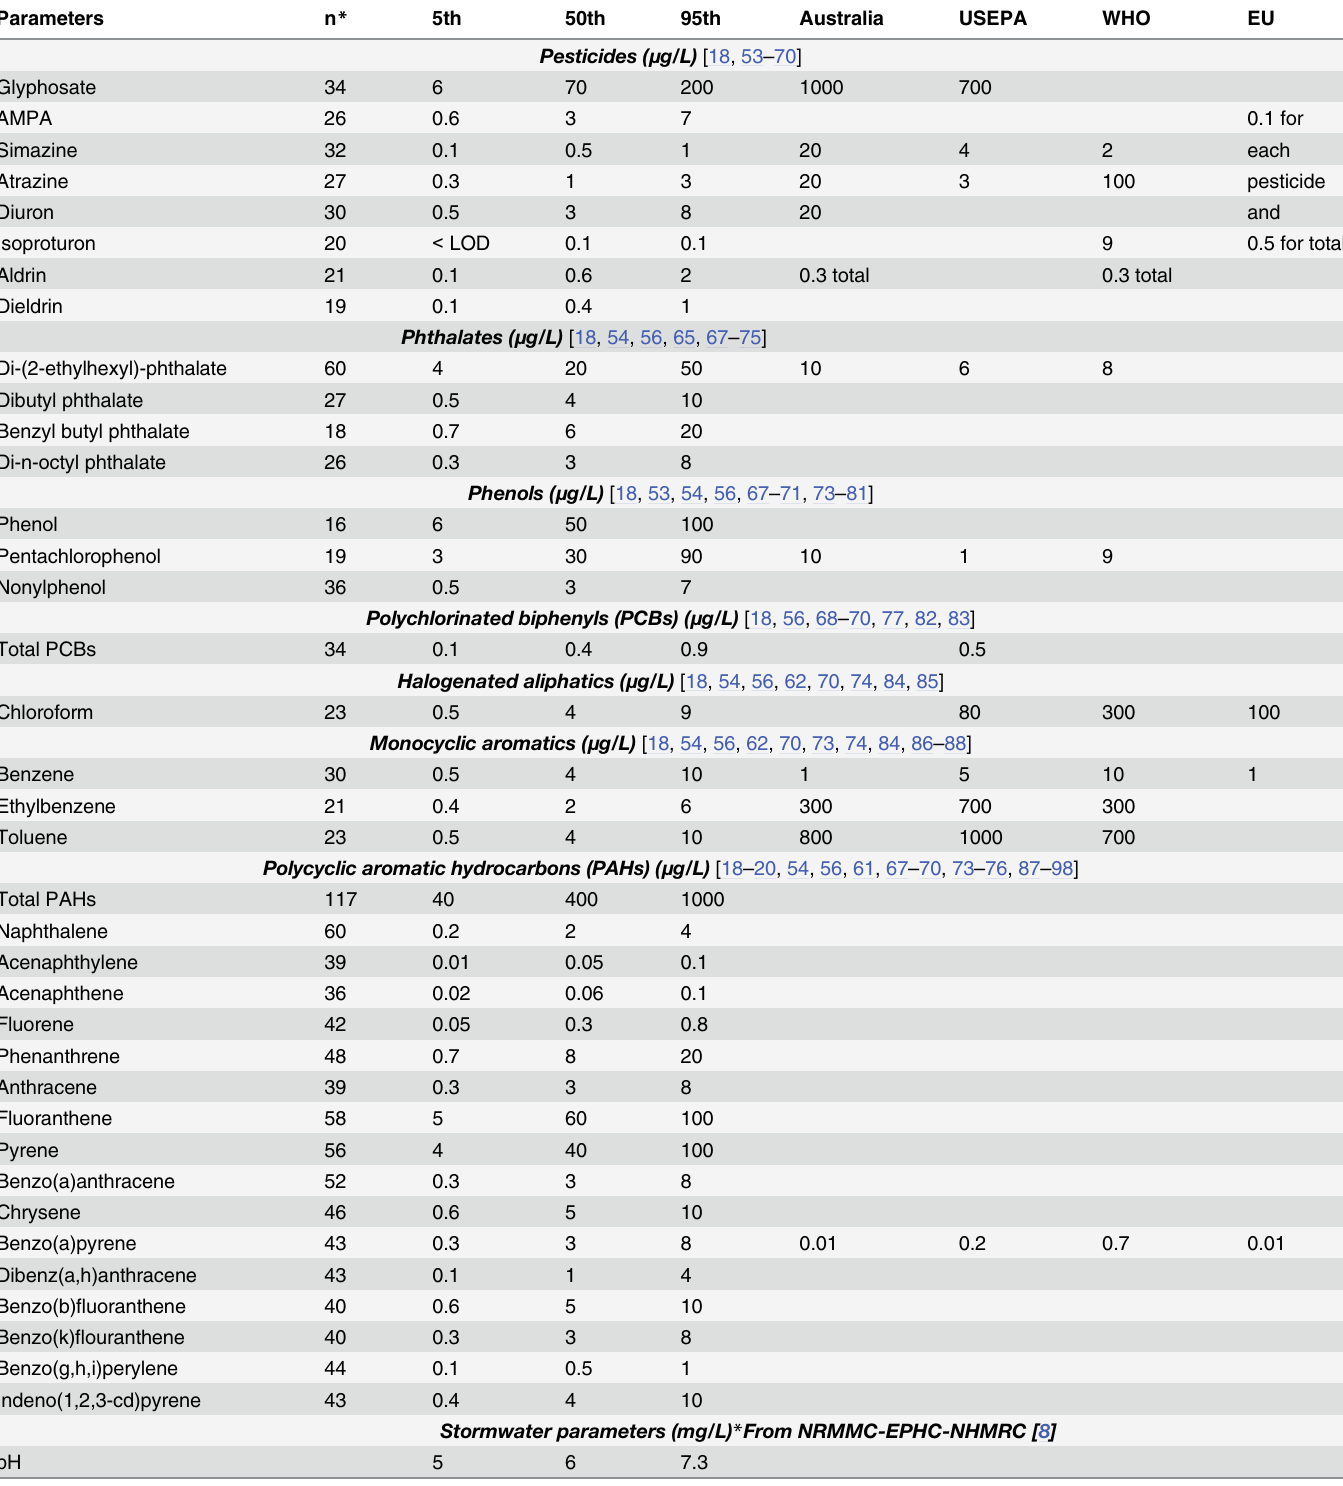
Table 3. 5 th , 50 th and 95 th percentile concentrations of micropollutant interpolated from literature and the corresponding drinking water guide- lines: Australia [33]; USEPA [35], WHO [34] and EU[36].